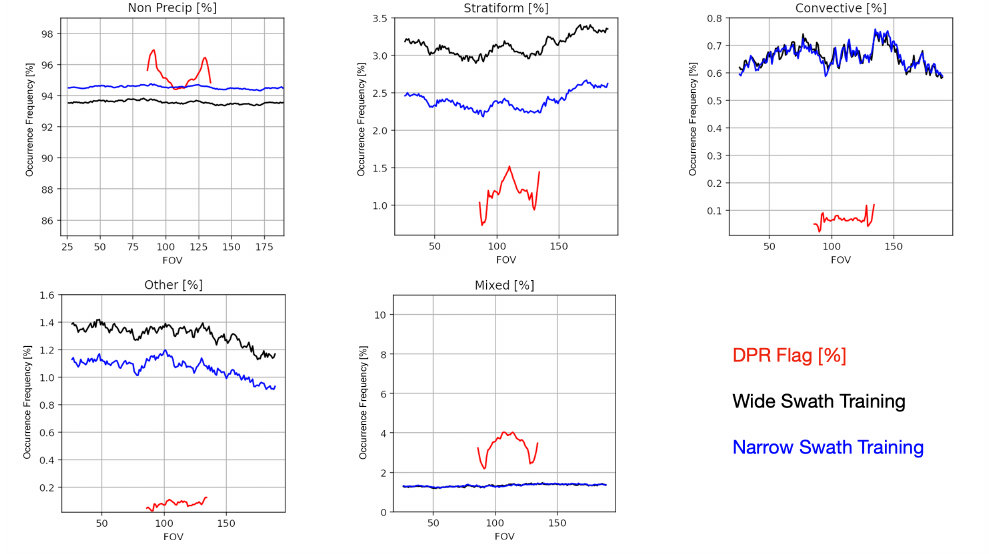
Figure 7. Same as Figure 6, except using CNN model, and only wide-swath training result is shown. Comparing the results generated from GB versus the CNN, the CNN’s prediction for nonprecipitation scenes were closer to that of the DPR. However, if we closely inspect the breakout from Figures 6 and 7, there is not much difference between them for stratiform, convective, and other precipitation types, except the CNN model predicts 50% more convective and 60% more other types of precipitation compared to GB and RF (not shown) results. All three models overestimated the monotype precipitations, which may likely not indicate a bias, but rather a sensitivity of GMI to light precipitation that DPR is not sensitive to. This was also found previously in [22,27]. A future sensitivity study using the MS as the “truth” could help better elucidate this point and quantify the difference. The GB results overpredicted the occurrence chance for the “mixed” class while the CNN showed the opposite result. Since the accuracy rate for the “mixed” class was low for all the models, it was not very meaningful to compare their